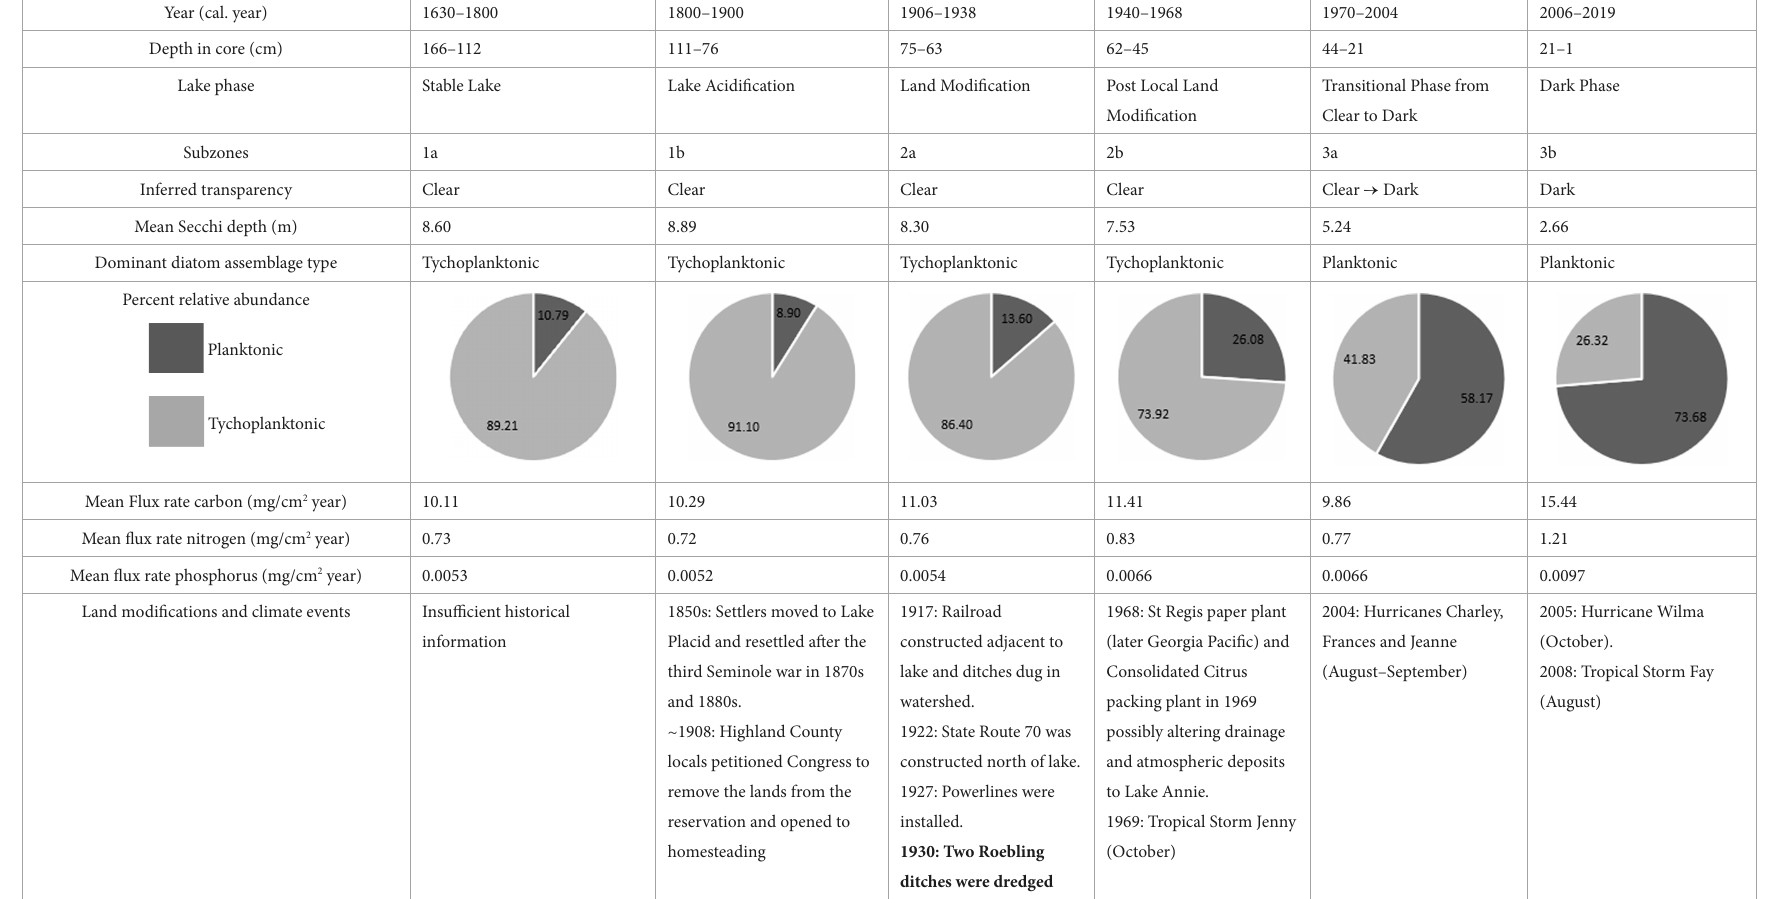
TABLE 1 Summary table of the Subzones including inferred transparency, percent relative abudance of planktonic and tychoplanktonic diatoms, mean flux rates of nutrients, and the potential land modifications and climate events that influenced the changes recorded in the sediments. Year (cal.